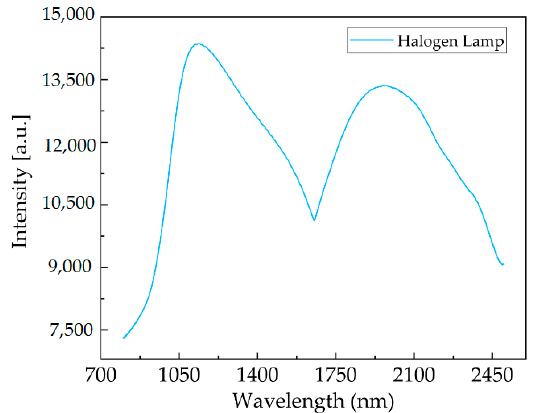
Figure 5. The correlated spectrum stitched from the wavelength of the halogen lamp.